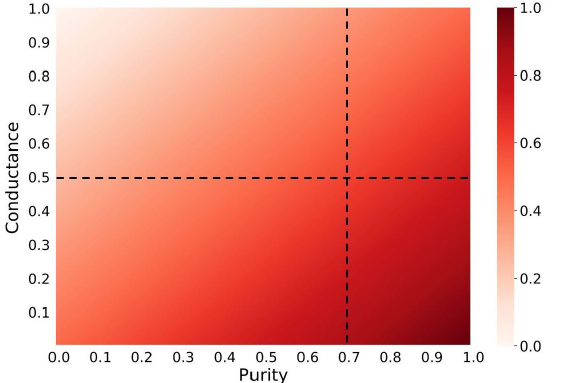
Figure 1. Risk for a community to be an echo chamber defined as the difference between Purity and Conductance. Red color implies a higher risk while white a lower one. The two dotted lines represent the constraints imposed in the Reddit case